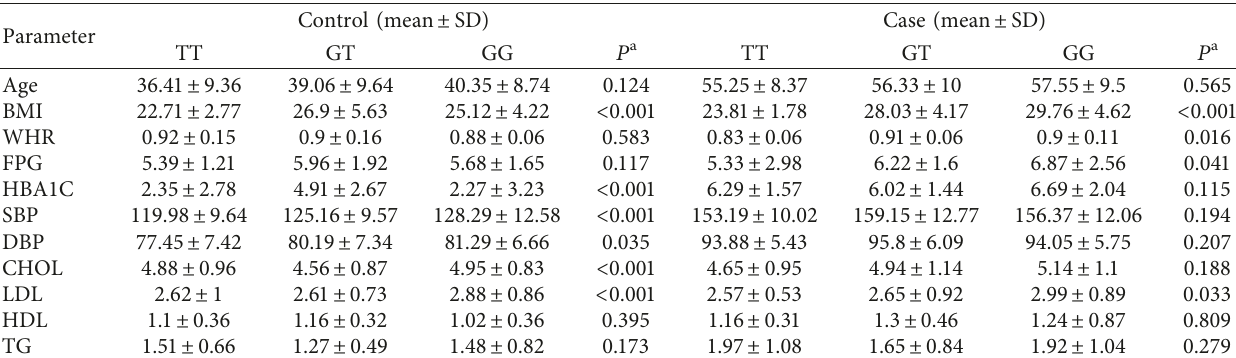
Table 4: Clinical and biochemical characteristics according to genotypes of ET-1 rs5370 gene